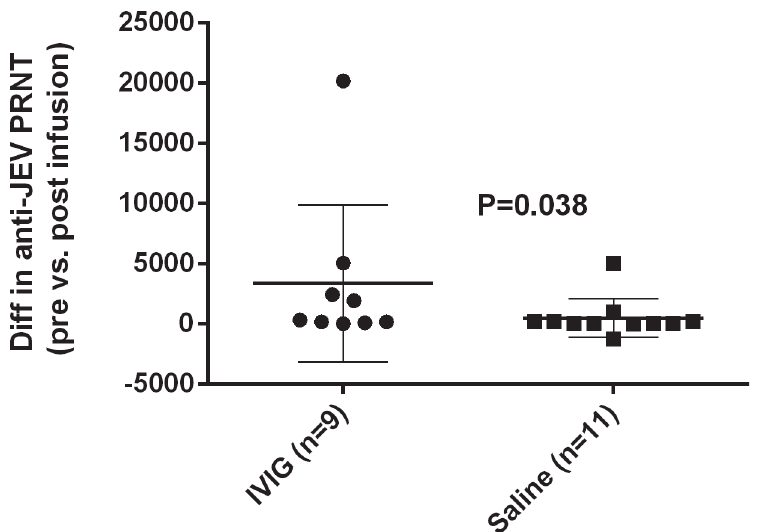
Fig 3. Difference in neutralizing antibody titres to JEV in children with acute encephalitis syndrome treated with IVIG or placebo. Median and inter-quartile range of the difference in JEV PRNT 50 titres pre and post treatment is presented. Patients are grouped according to treatment. Difference in tires was assessed via Wilcoxon-Mann-Whitney test. Note: Two patients who received IVIG were not included in this analysis because of insufficient sample to undertake PRNT